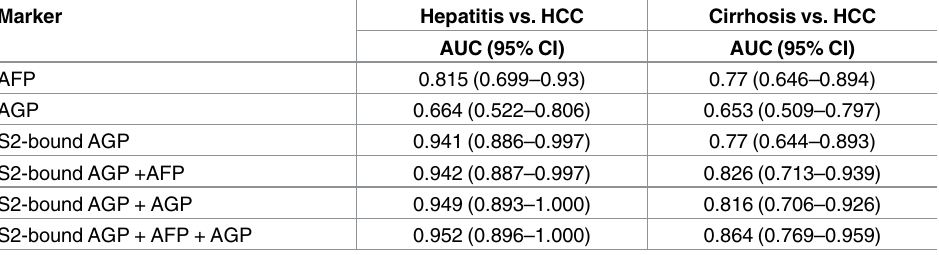
Table 2. ROC-analysis (HCC vs. hepatitis and cirrhosis). Marker Hepatitis vs.